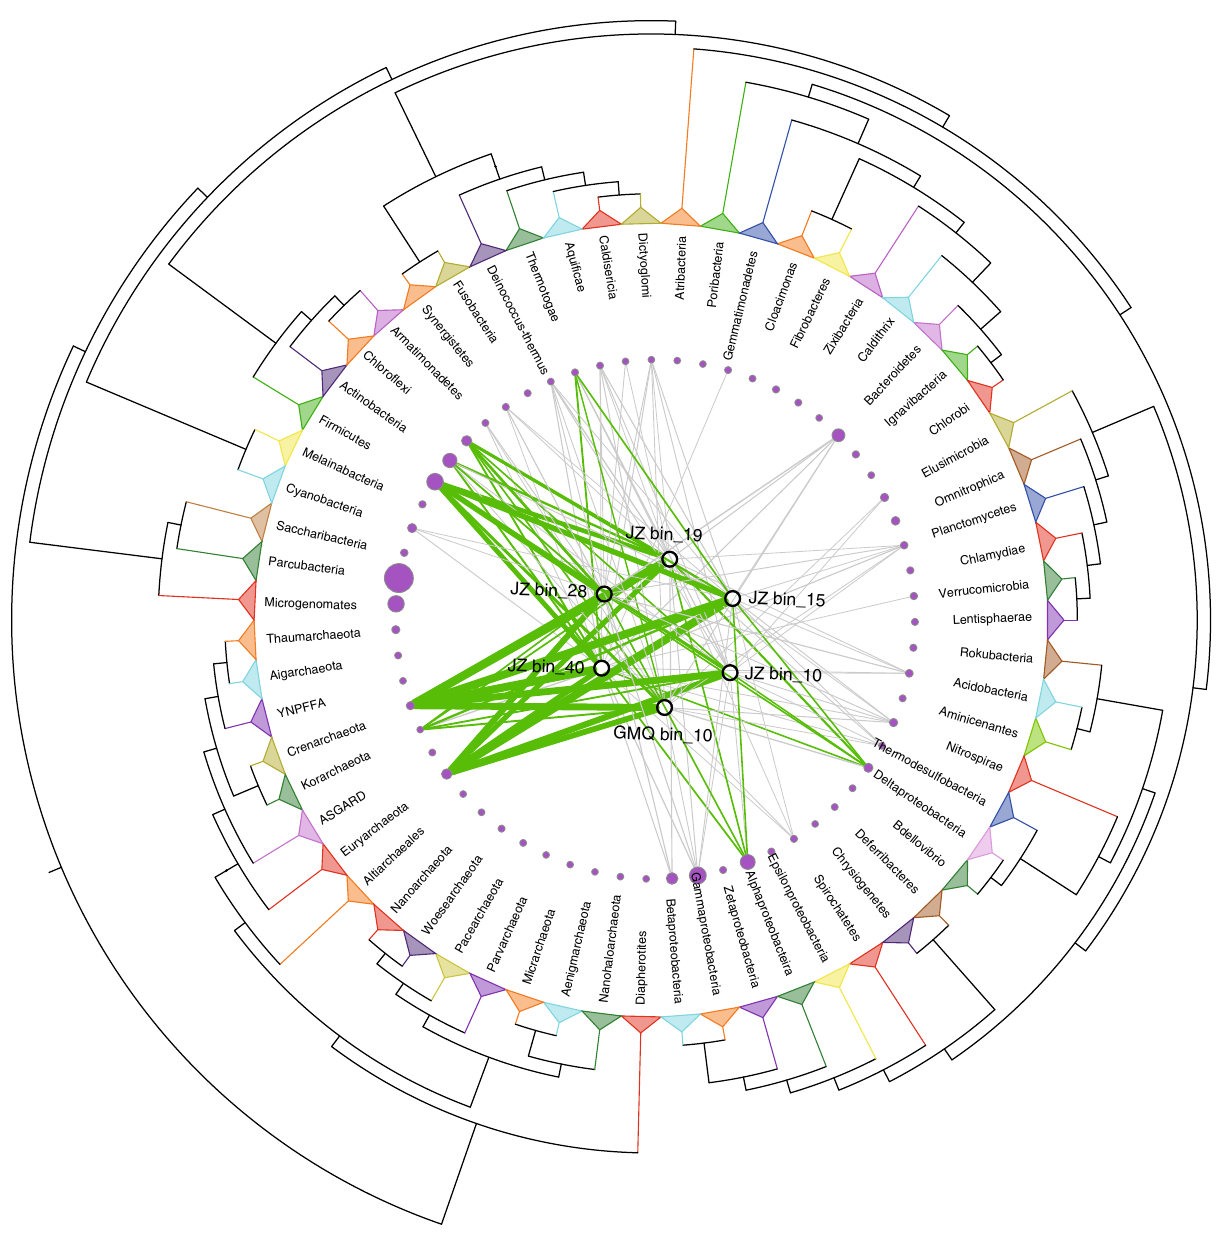
Fig. 4 Extensive horizontal gene transfer events detected in Aigarchaeota. The maximum likelihood tree was pruned and redrawn at the phylum level according to the tree of life published by Hug et al. 79 . Green edges represent potential gene fl ows from the corresponding phylum involving ≥ 10 genes, and gray lines are the ones with <10 genes. Edge thickness is proportional to the number of putatively transferred genes. The sizes of red circles are proportional to the number of reference genomes collected for that